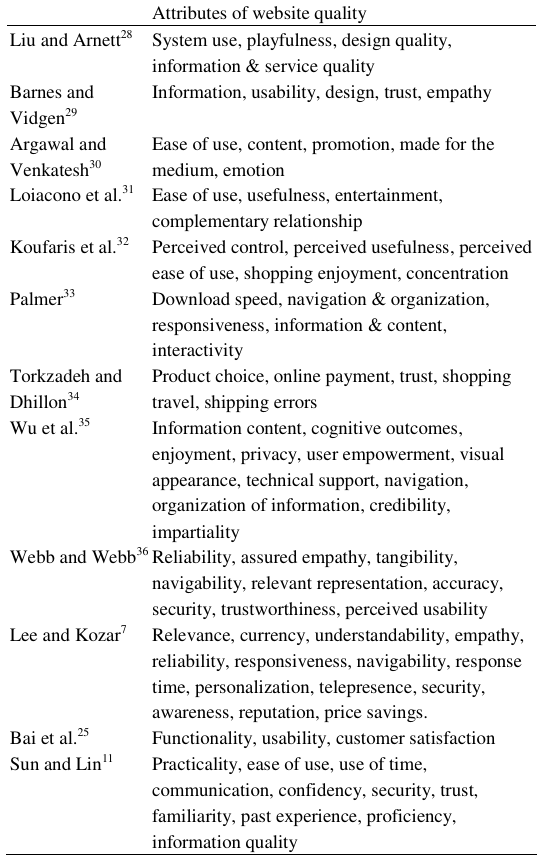
~ Figure 1: A Fuzzy Number τ